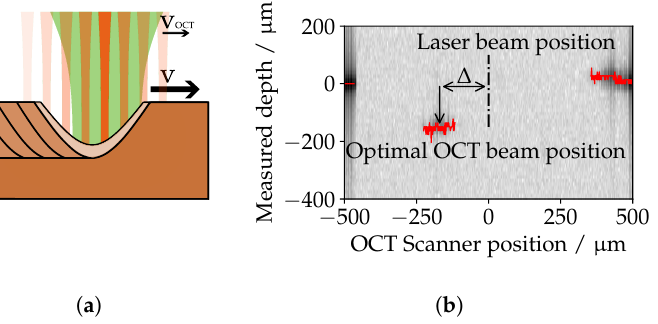
Figure 5. ( a ) Schematic illustration of the OCT beam movement during the welding process for determining the optimal lag distance of the OCT beam; ( b ) exemplary measurement result for determining the optimal lag distance.